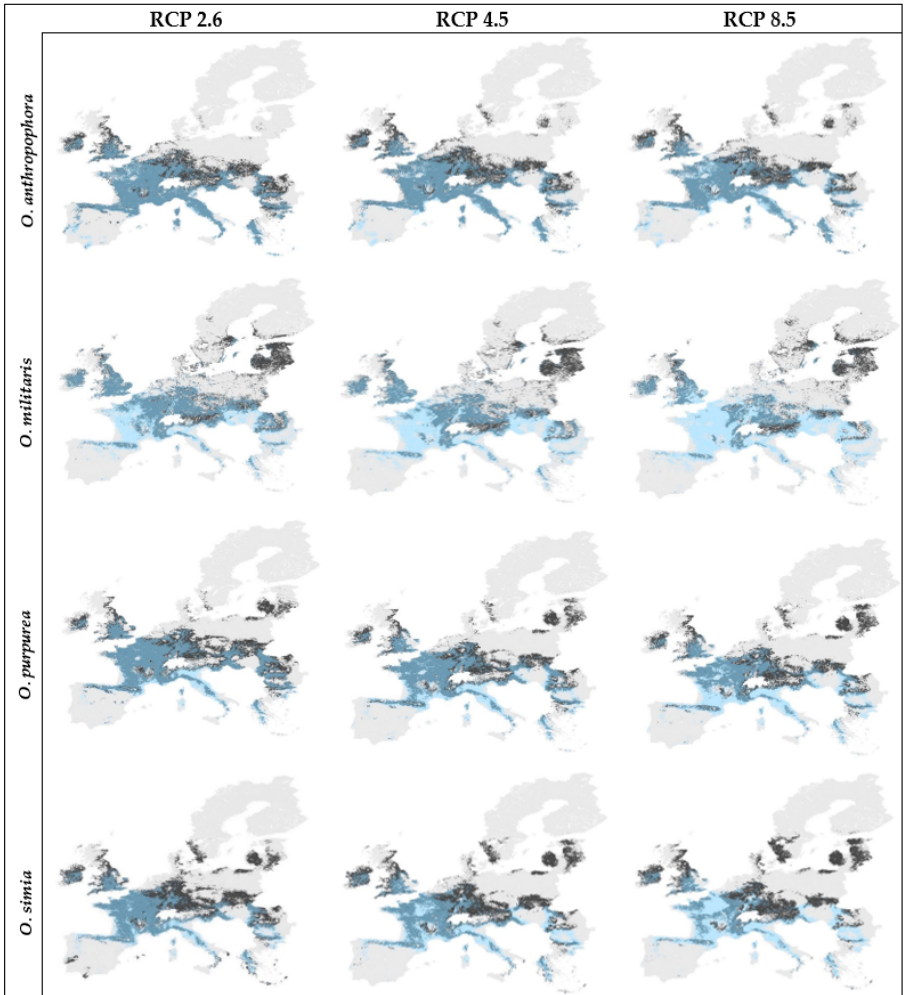
Figure 2. Habitat distributions for four Orchis species in Europe, predicted by Maxent based on abiotic environmental variables, for the current climate and three increasingly severe climate scenarios predicted for 2050 (RCP 2.6, 4.5 and 8.5). Light blue areas represent the current distributions, black areas represent the future distributions and the dark blue areas represent the habitat that is available in both current and future scenarios.